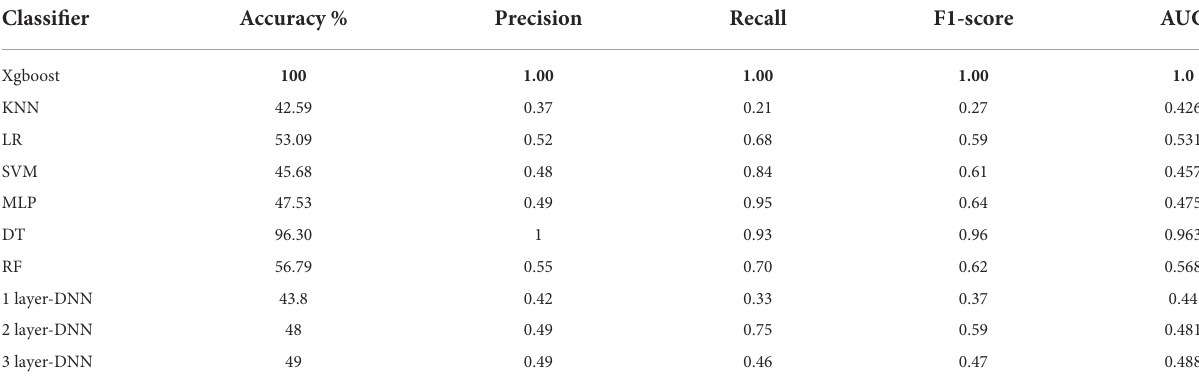
TABLE 5 The performance of all Ml models and DNN for detection of DR using a combination of ResNet-50 and retinal lesion features.